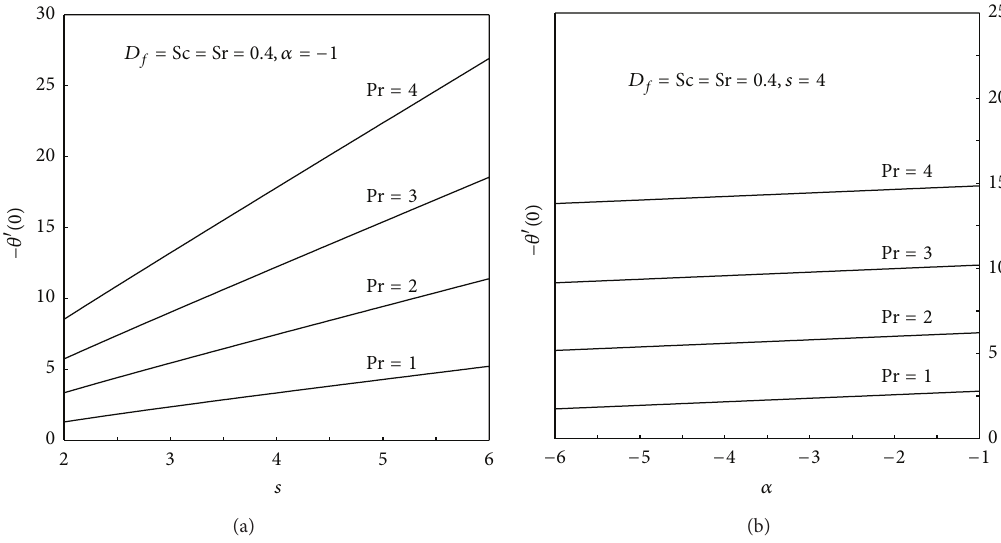
Figure 6: (a) Wall heat flux, −𝜃 󸀠 (0) with 𝑠 for various values of Pr. (b) Wall heat flux, −𝜃 󸀠 (0) with 𝛼 for various values of Pr.